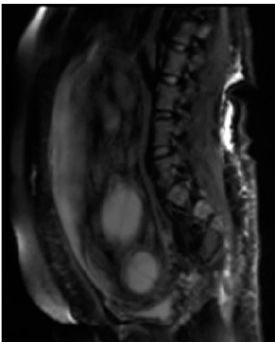
Figure 2. Diffusion Weighted Imaging